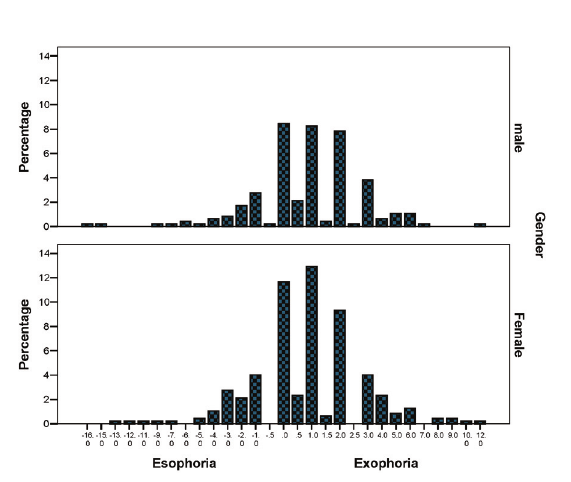
Figure 5 Distribution of distance horizontal heterophoria according to gender. A large proportion (both males and females) is exophoric with a peak at orthophoria (males) and 1 pd exophoria (females)